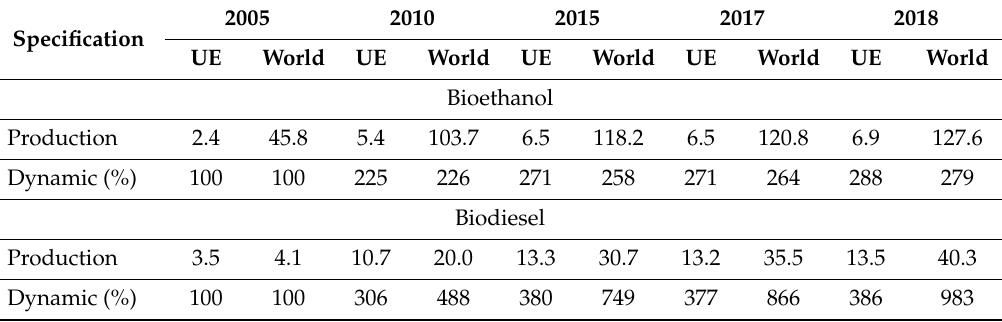
Table 1. First generation biofuel production (billion